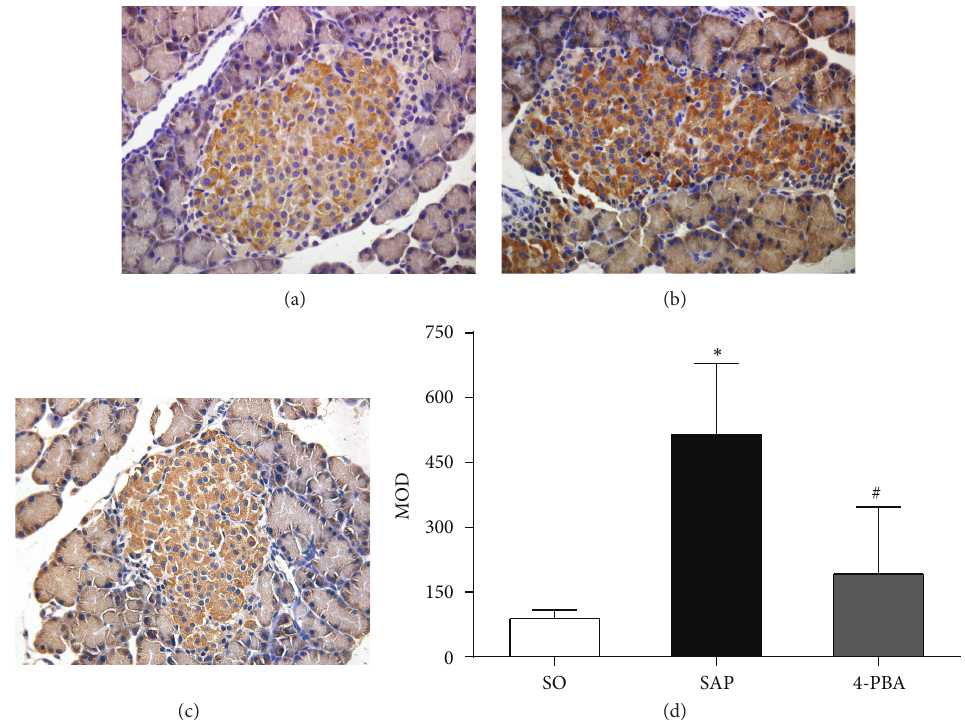
Figure 7: Immunohistochemical expression of ORP150 in pancreatic islets (original magnification, × 400). (a) SO group; (b) SAP group; (c) 4-PBA group. (d) Comparison of MOD of ORP150 in all groups. Each value represents the mean ± standard deviation. ∗ 𝑃 < 0.05 versus SO group; # 𝑃 < 0.05 versus SAP